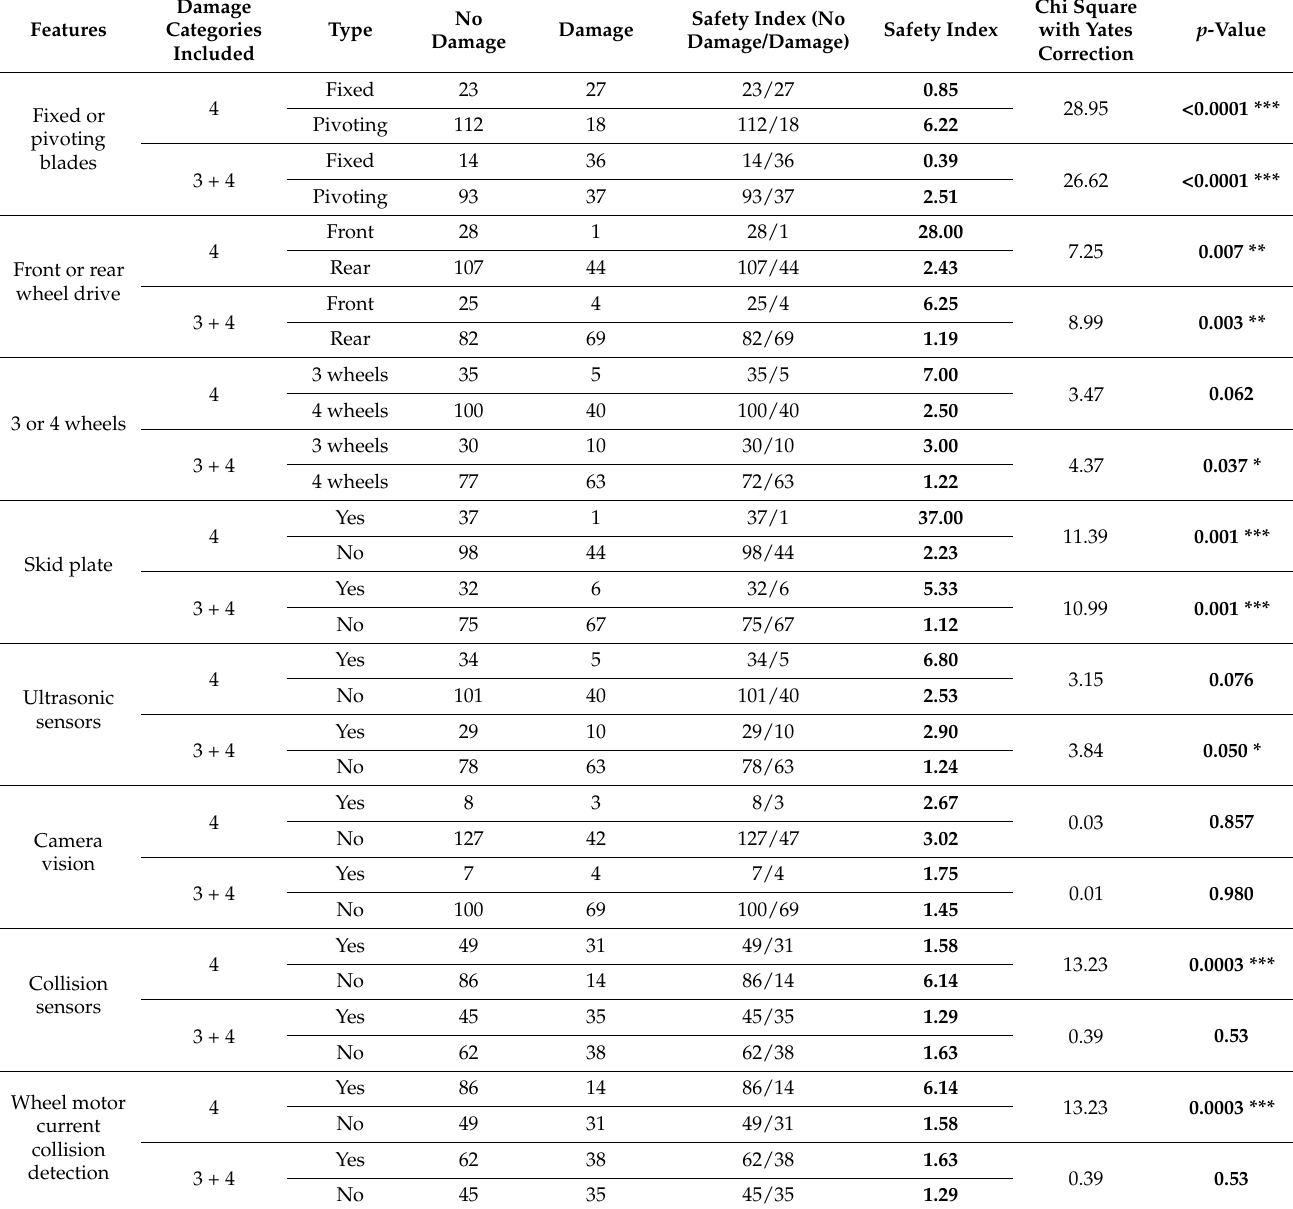
Table 3. Results from the data analyses investigating if the presence or absence of a given technical feature on a robotic lawn mower significantly influenced the safety index. Damage category A was omitted from the